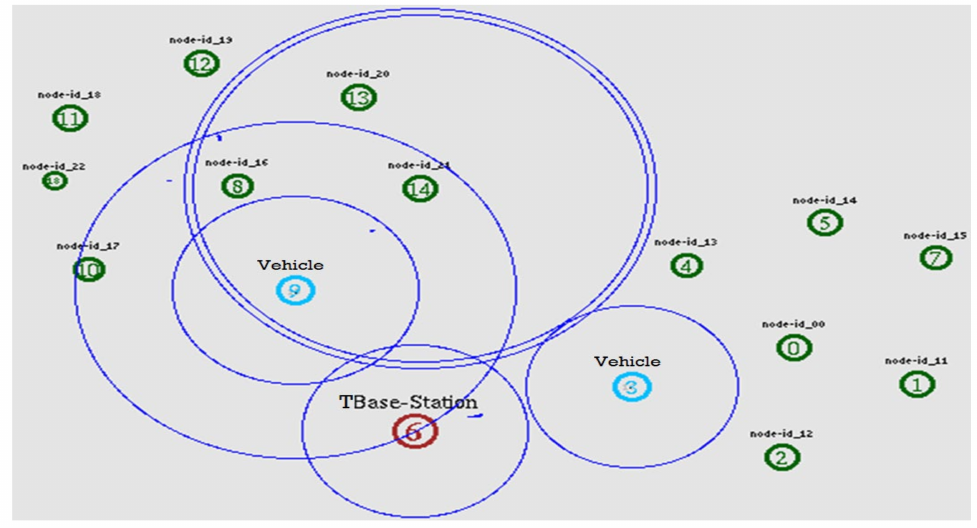
Figure 10. Creation of V j s and TBS using